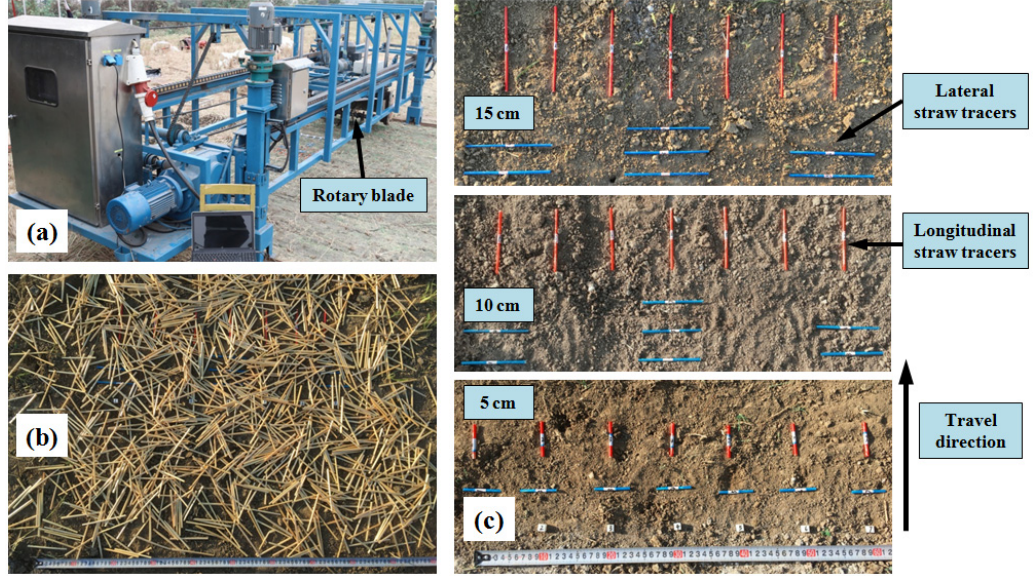
Figure 3. Straw preparation ( a ) place field test bench, ( b ) place straw tracers and surface straws, ( c ) examples of straw tracers.